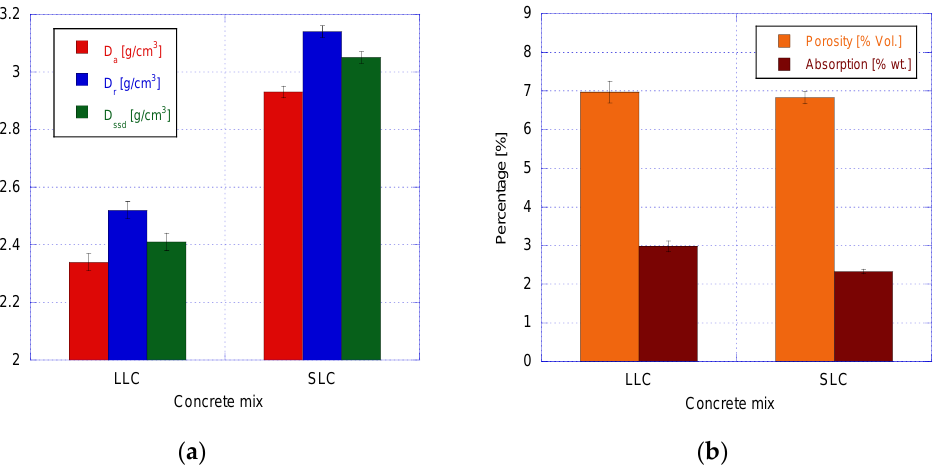
Figure 4. Physical properties of the mixes produced; ( a ) densities and ( b ) porosity and absorption.